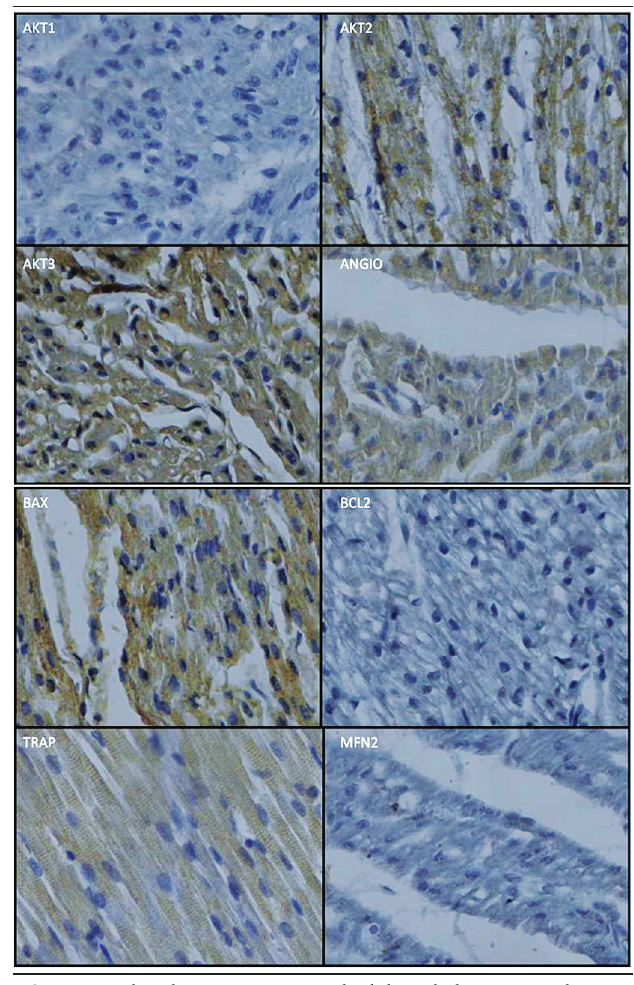
figurE − Histological sections immunostained with the antibodies anti-BAX, Bcl2, TRAP1, Mfn2, Akt1, Akt2, Akt3 and angiotensin II BAX: B-cell lymphoma 2 (Bcl2)-associated X protein; TRAP1: tumor necrosis factor receptor- associated protein 1; Mfn2: mitofusin-2; Akt: